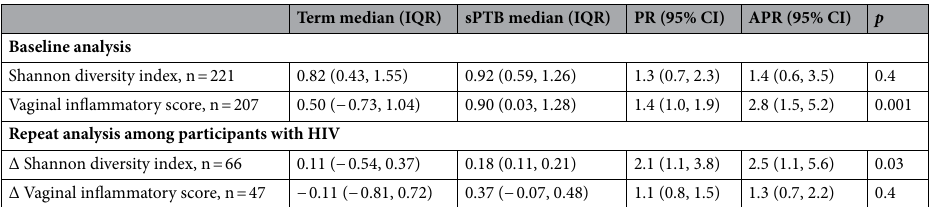
Table 6. Shannon diversity index and vaginal inflammatory scores at baseline (16–24 weeks) and the change (Δ) from baseline to repeat (24–36 gestational weeks) between participants experiencing term birth and spontaneous preterm birth (sPTB). Multivariable model estimates of the prevalence of spontaneous preterm birth (APR) calculated by weighted Poisson regression with robust error variance and adjusted for HIV serostatus (in baseline models) or detectable viral load (in change models), maternal age, body mass index, parity, and prior